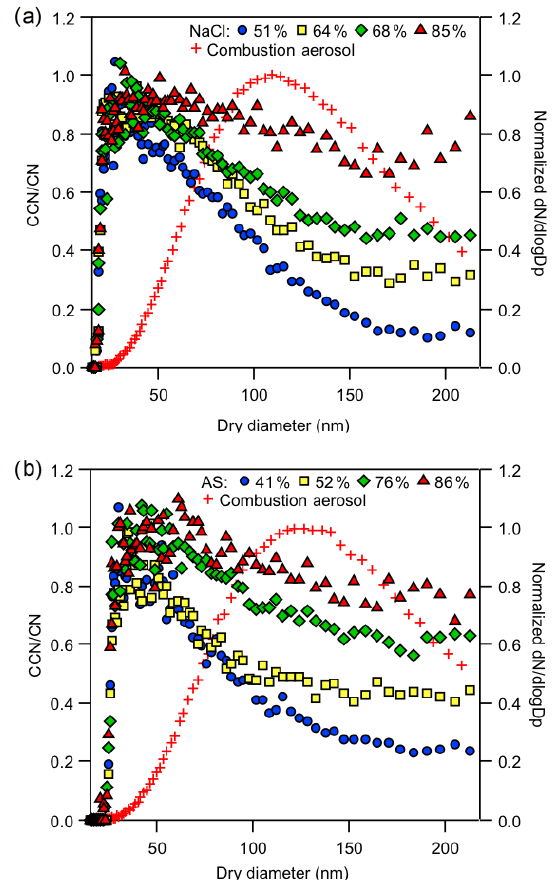
Figure 8. Combustion aerosols externally mixed with inorganics. (a) NaCl externally mixed with concentrations modified from 51% to 85% over the course of 60min. (b) AS externally mixed with concentrations from 41% to 86% over the course of 75min. Cross symbols represent the initial size distribution of the combustion